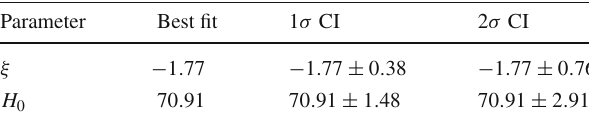
Table 2 The best-fit values of the parameter ξ and of the present day value of the Hubble function H 0 for the general conformally invariant quadratic Weyl model